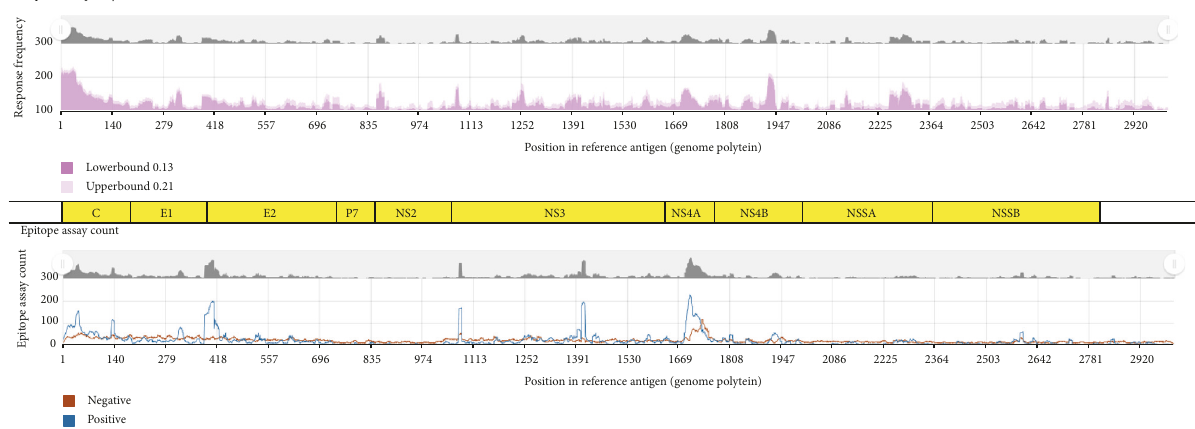
Figure 4: The Immunome Browser maps response frequencies and assay counts onto a reference antigen. The polyprotein for HCV is superimposed on the plots for reference. The data re fl ects IEDB HCV content as of October